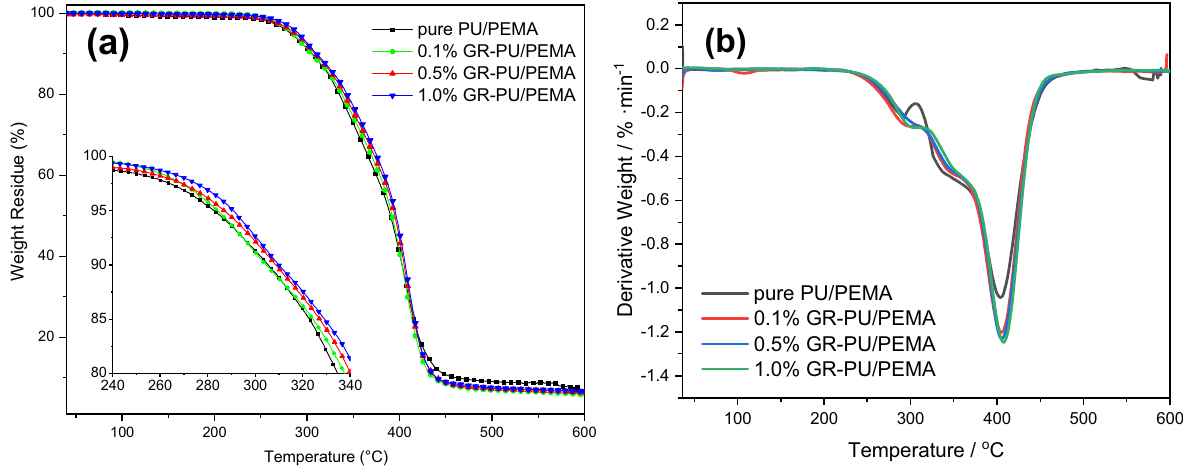
Figure 9: ( a ) TGA and ( b ) DTG curves for GR - PU/PEMA, 0.1 wt% GR - PU/PEMA, 0.5 wt% GR - PU/PEMA, and 1.0 wt% GR - PU/PEMA composites.